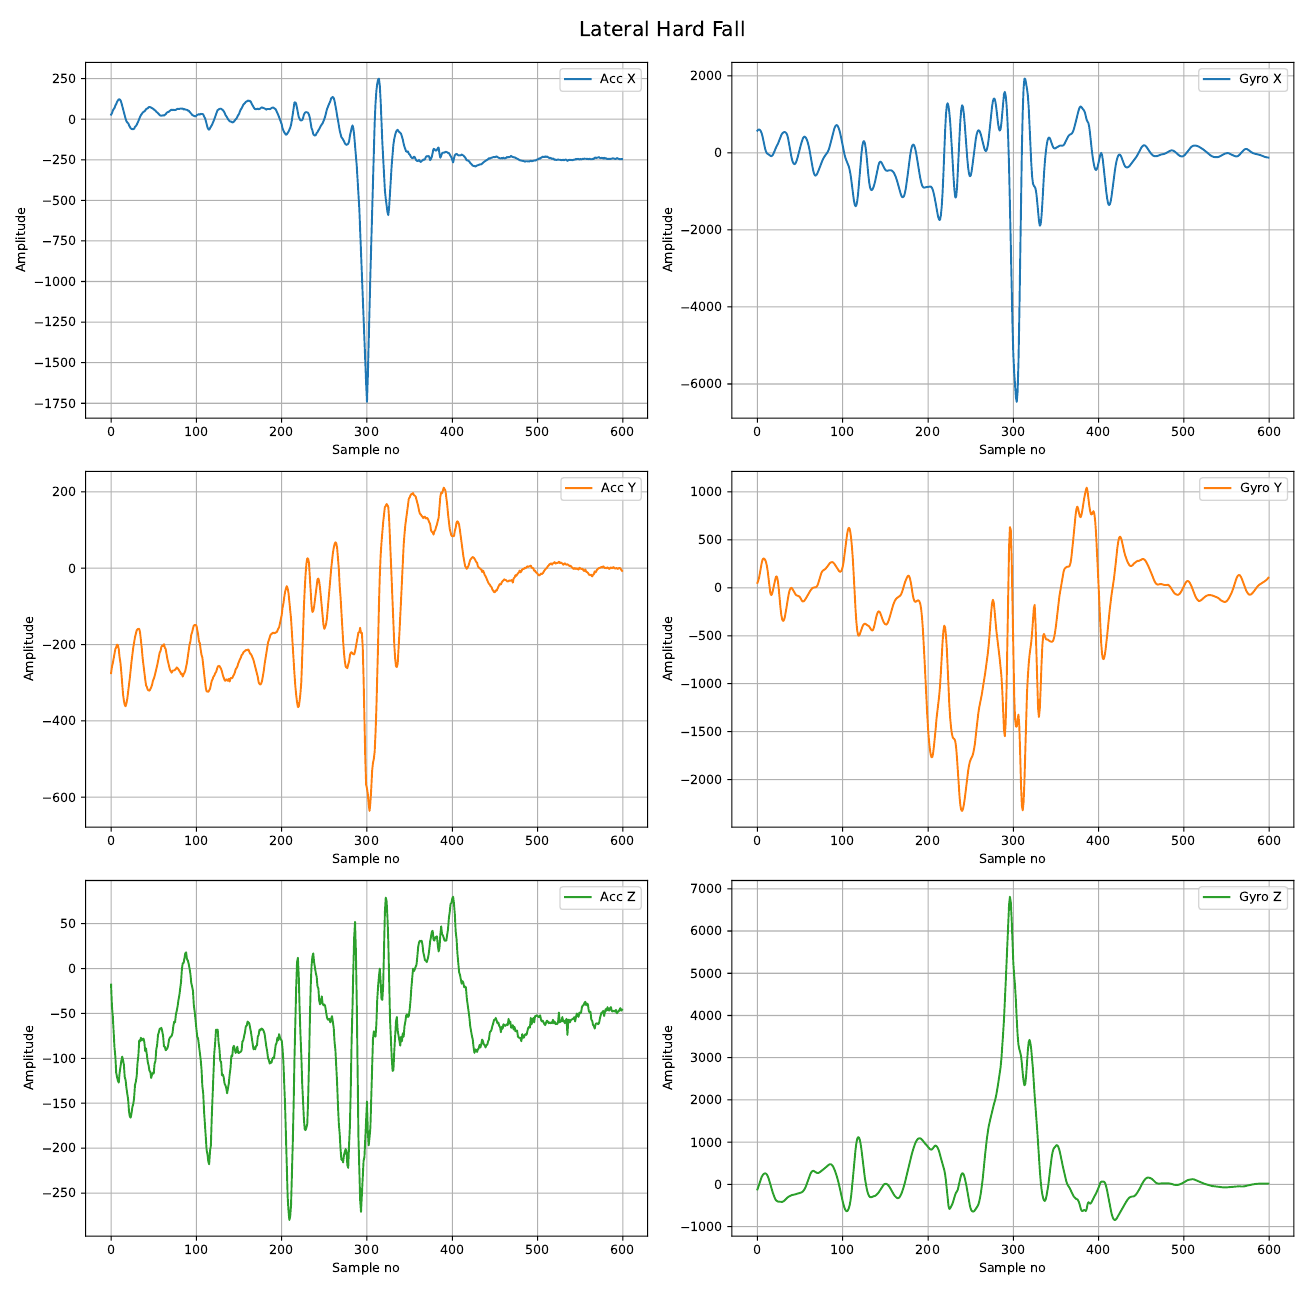
Figure A5. Accelerometer and gyroscope measurements: lateral hard